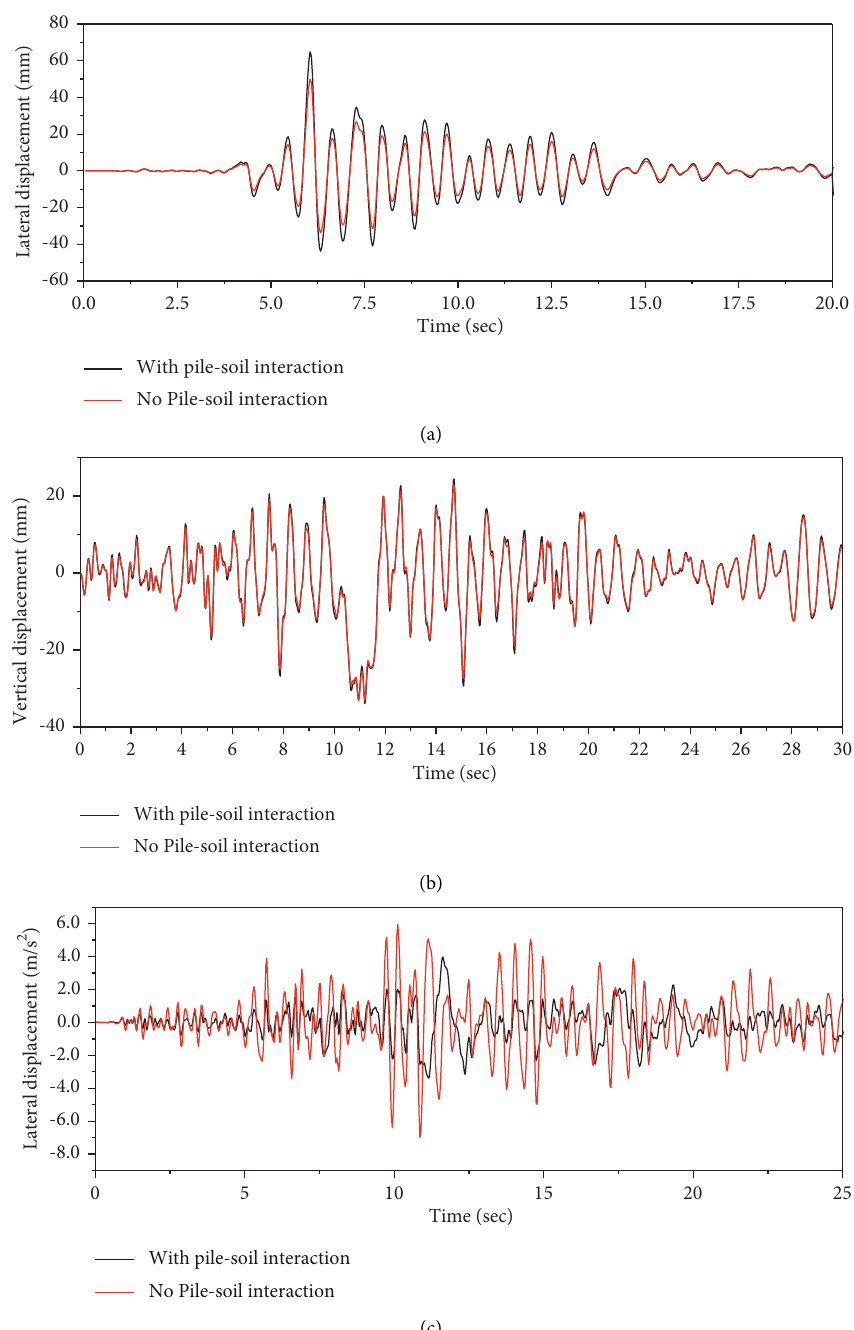
Figure 3: Time-history curves of the comparison of two models considering pile-soil interaction and without interaction: (a) Loma Prieta 1989 lateral displacement of beams in span under earthquake action; (b) Hector Mine 1999 Vertical mid-span displacement of beams under seismic action; (c) Kocaeli Turkey 1999 transverse acceleration in the span of a beam under seismic